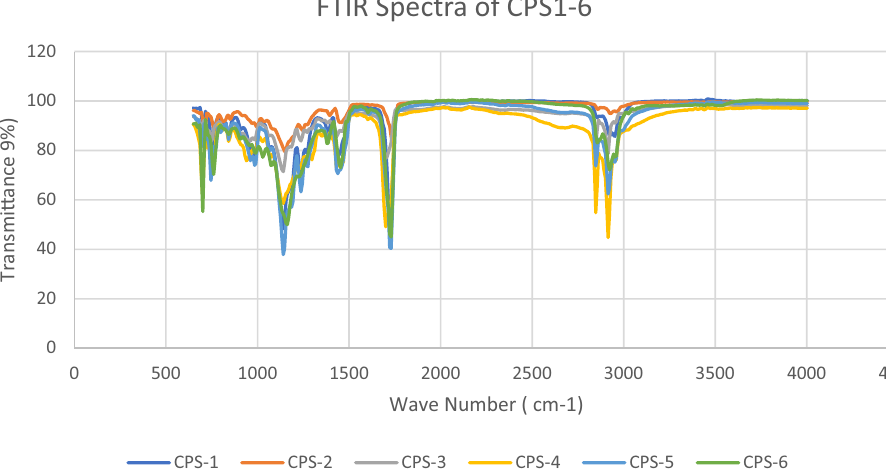
Figure 3. FTIR Spectra of CPS1-6.